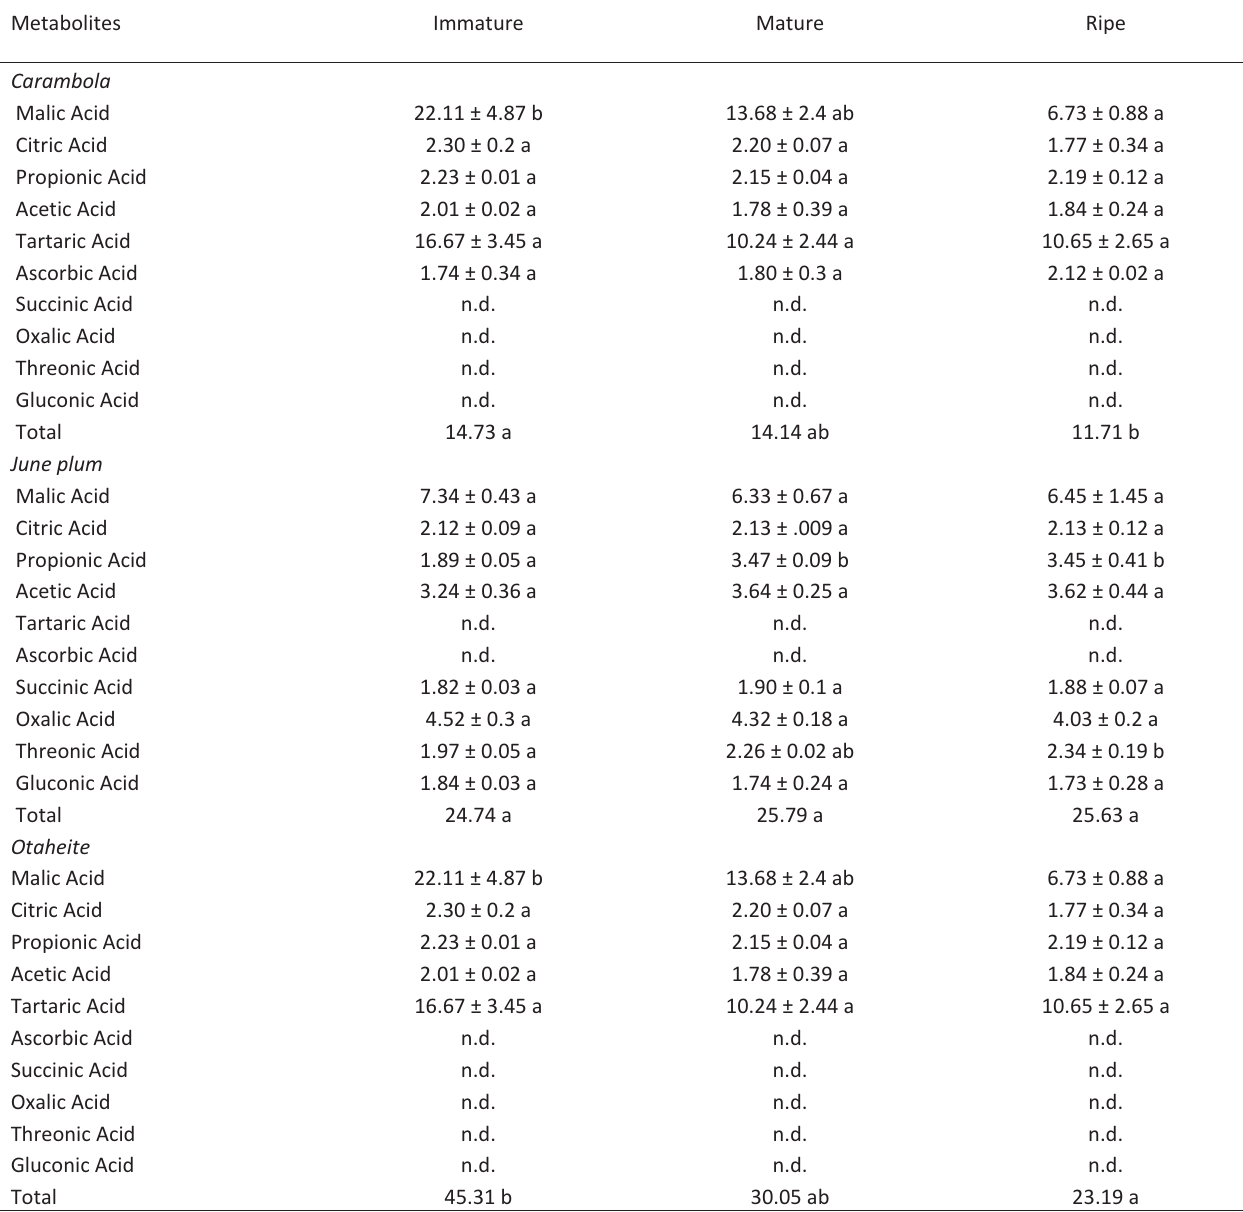
Different letters of the same row indicate significant difference at P= 0.05. n.d. = not detected.